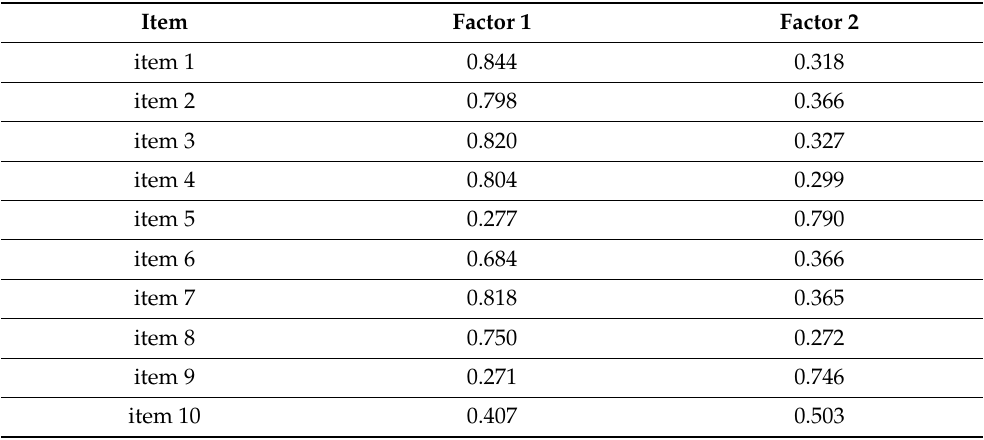
Table 5. Factor loadings extracted with the maximum likelihood method and rotated with the varimax method.